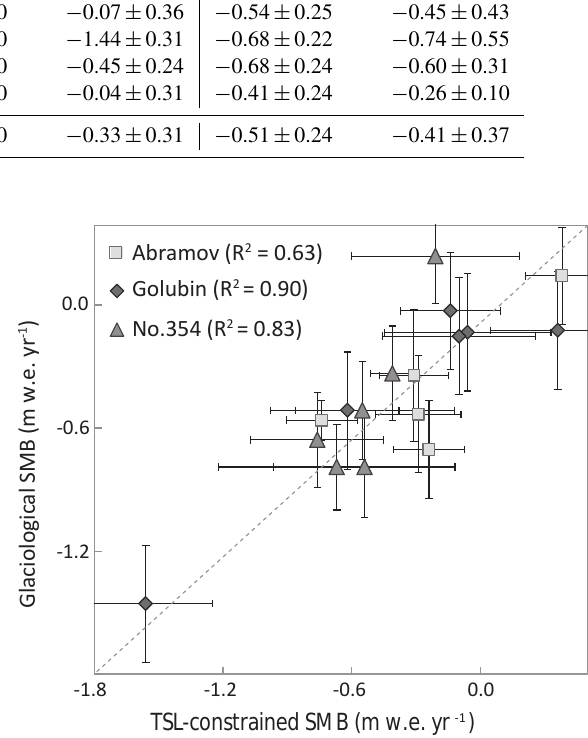
Figure 8. Modelled annual SMB B sfc ( fix ) constrained by snow line observations for all three glaciers for each hydrological year. Table 7. Annual SMB B sfc ( meas ) for the measurement periods (i.e. exact dates of the surveys, Table 2) based on direct glaciological mea- surements and on the TSL-constrained model for the three glaciers in mw.eyr − 1 . Abramov Golubin Glacier no. 354 Year Glaciological TSL-constrained Glaciological TSL-constrained Glaciological TSL-constrained − 0.06 ± 0.30